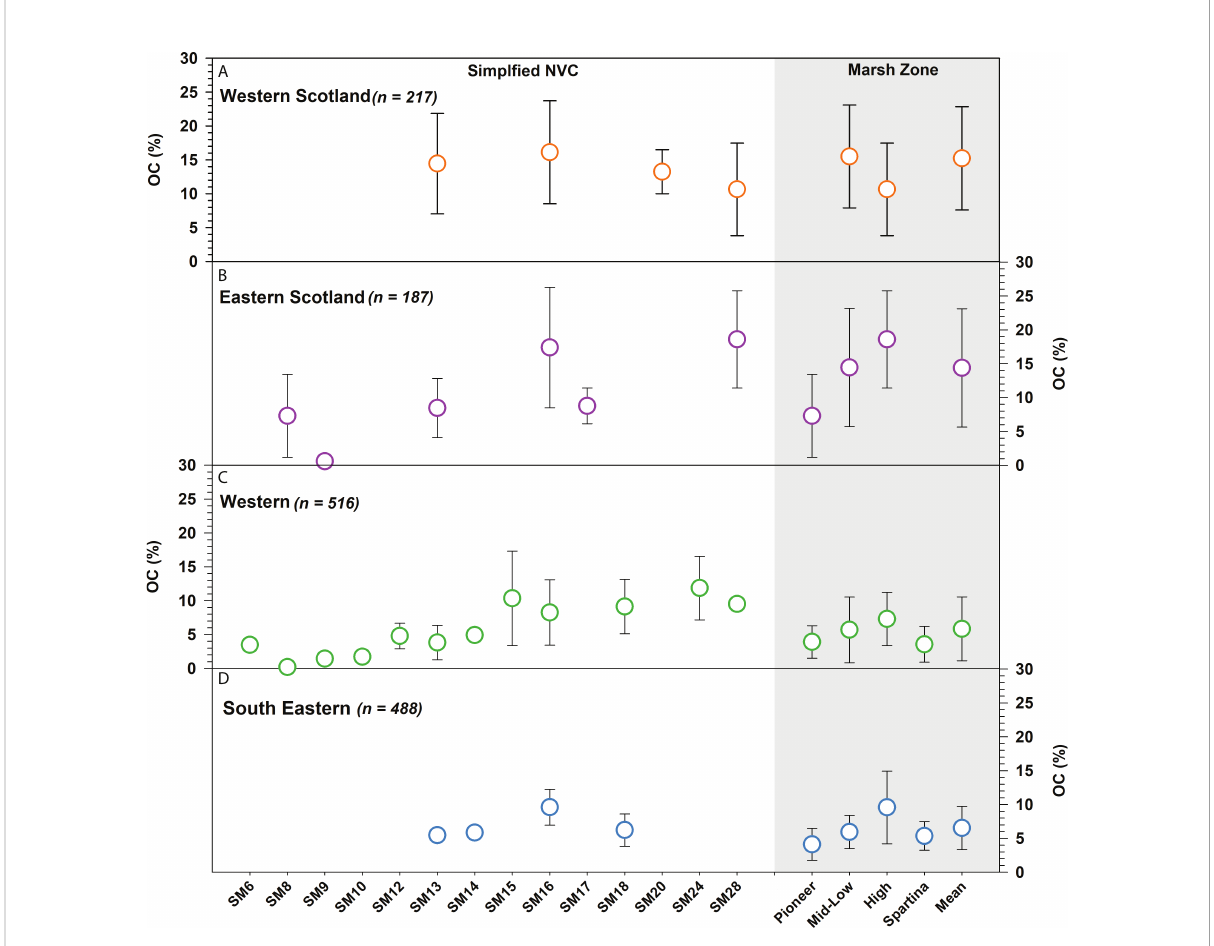
FIGURE 5 Soil OC content (%) values associated with different saltmarsh vegetation and zones across the four geo-regions (A – D) of Great Britain. Error bars represent 1s. Full breakdown of the OC data can be found in Supplementary Figure 4 and Supplementary Table